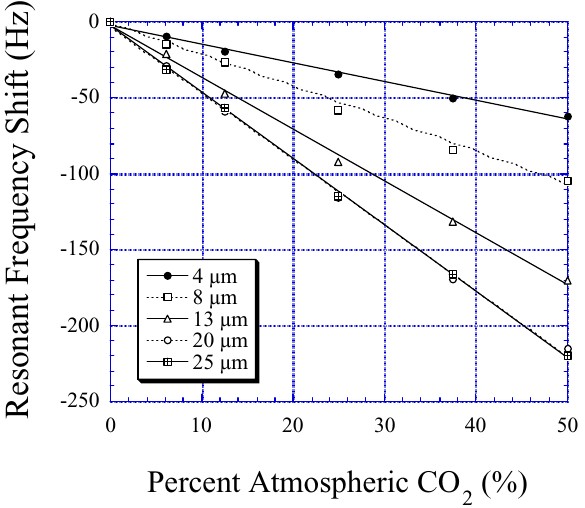
, NH , pH, and glucose based 2 3